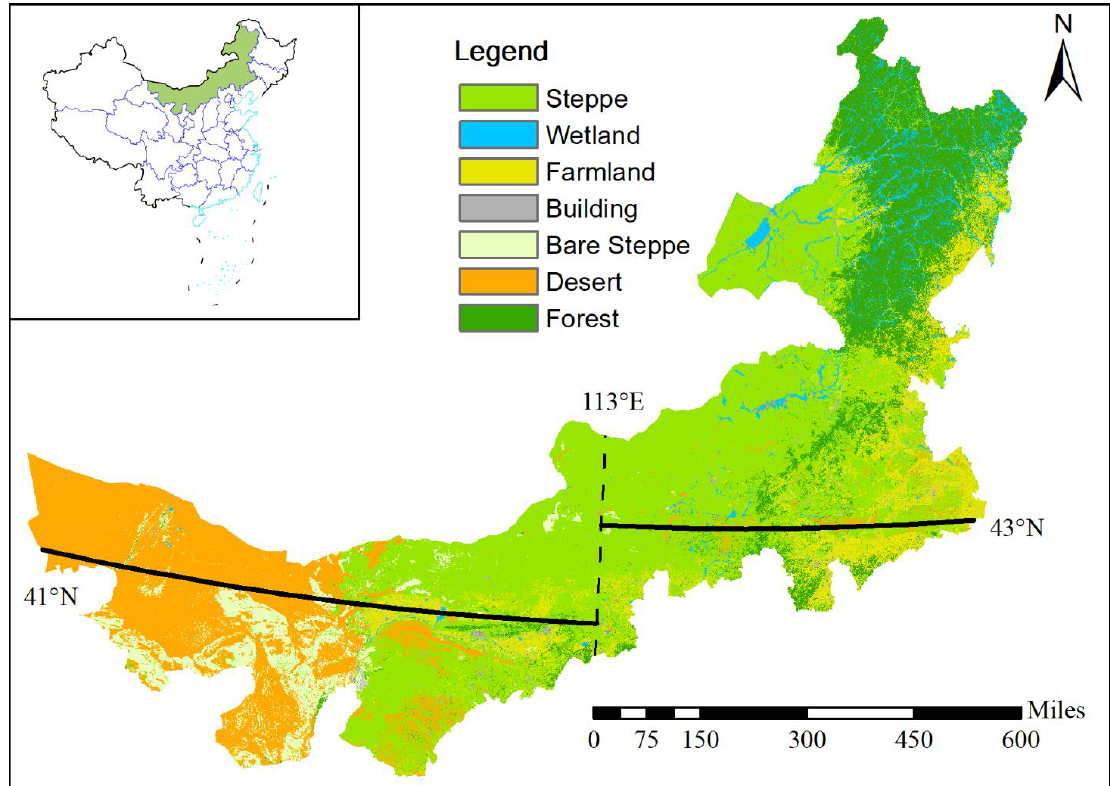
Figure 1. The study area of Inner Mongolia Plateau and the east – west transects.